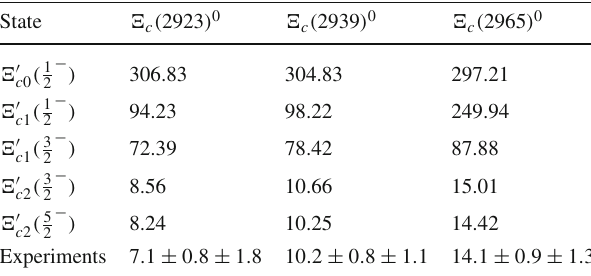
Table 6 Total decay widths of the (cid:2) c ( 2923 ) 0 , (cid:2) c ( 2939 ) 0 , and (cid:2)